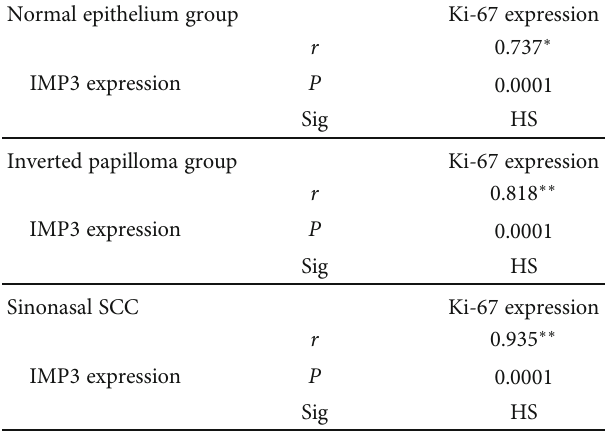
Table 5: Correlation between IMP3 and Ki-67 expression among the three studied groups.